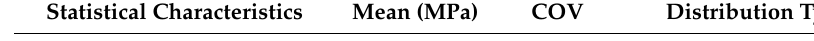
Table 1. Statistical characteristics of CFRP [33].